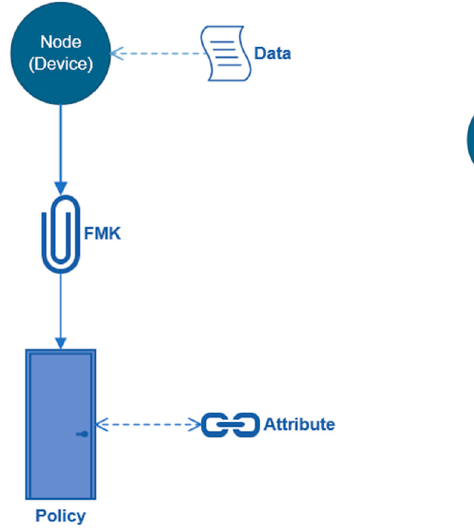
Figure 7. ( a ) The first test based on a single node; and, ( b ) The second test based on multiple nodes.